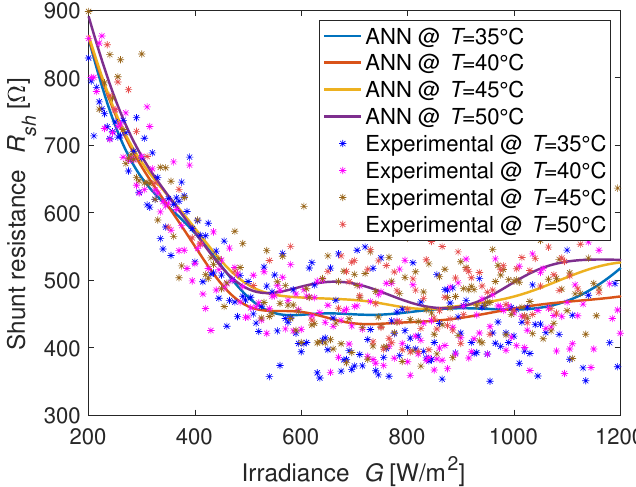
Figure 10. ANN identification of the shunt resistance in healthy